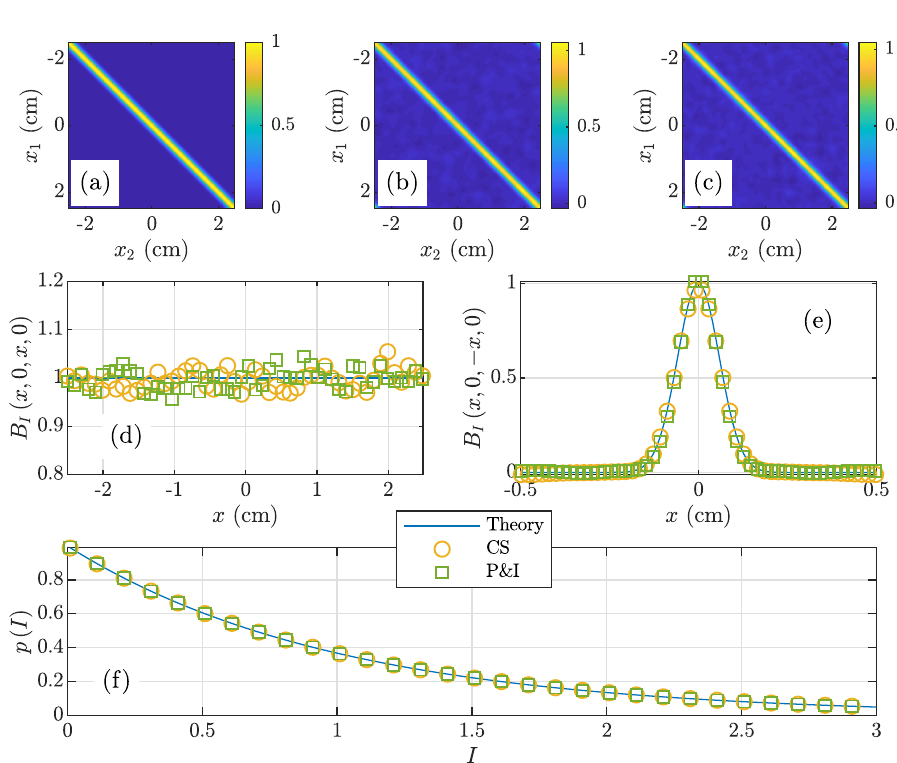
Figure 3. GSM beam irradiance results—( a ) theory, ( b ) CS, and ( c ) P&I B I ( x 1 ,0, x 2 ,0 ) ; ( d ) theory, CS, and P&I B I ( x ,0, x ,0 ) ; ( e ) theory, CS, and P&I B I ( x ,0, − x ,0 ) ; and ( f ) theory, CS, and P&I irra- diance PDFs. The CS and P&I field expressions are given in Equations (A5) and (2), respectively. The theoretical irradiance PDF and covariance of irradiance are given in Equations (27) and (28),